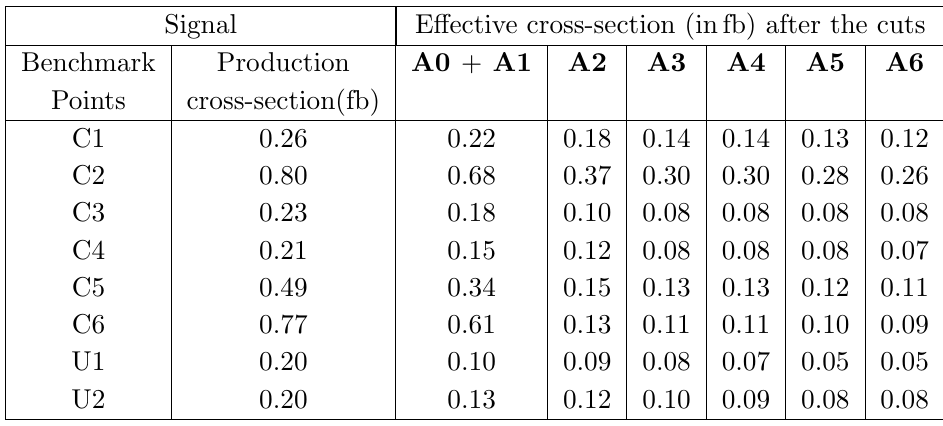
Table 2 . Signal Cross-sections (NLO+NLL) for all the benchmark points listed in table 1 corre- sponding to ( (cid:21) 1 (cid:13) + > 2 jets + E= T ) (cid:12)nal state. For all the points, m